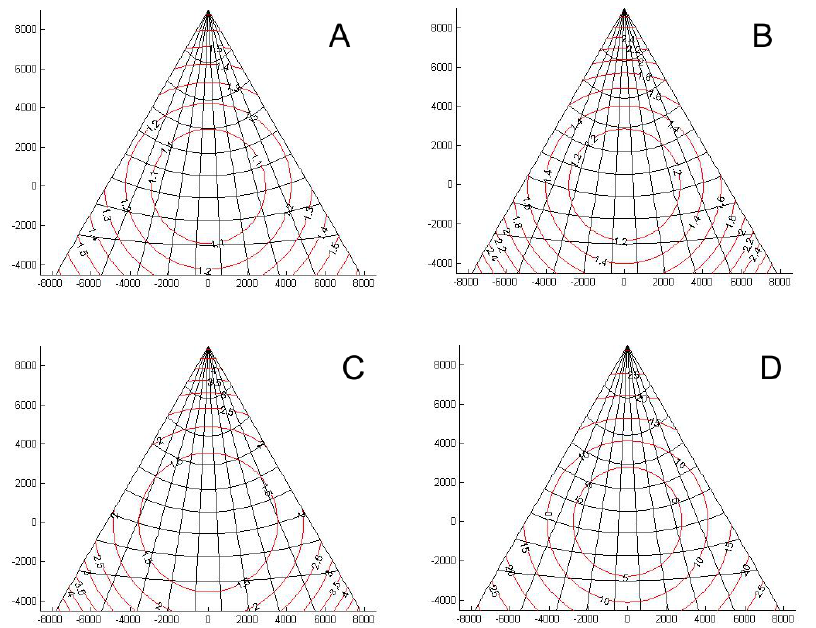
Fig. 24A. Distribution of distortion in gnomonic projection of one of the faces of a regular octahedron: A – isolines of extreme scales of distortion of length m ; B – isolines of extreme scales of distortion of length n ; C – isolines of scales of area distortion; D – isolines of extreme angular